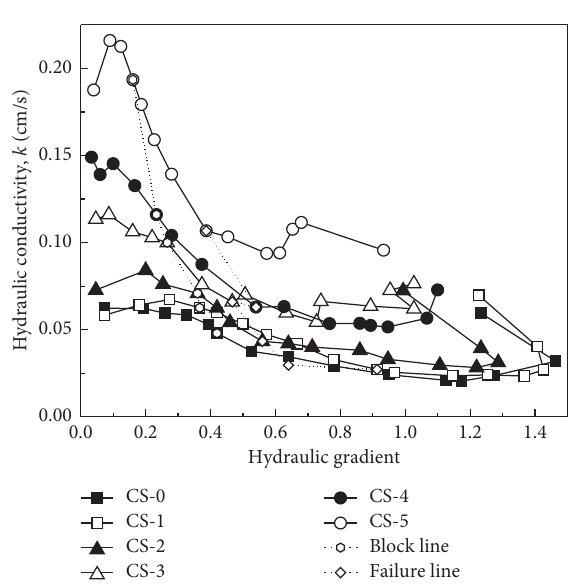
Figure 12: Variation of hydraulic conductivity with hydraulic gradient of CS